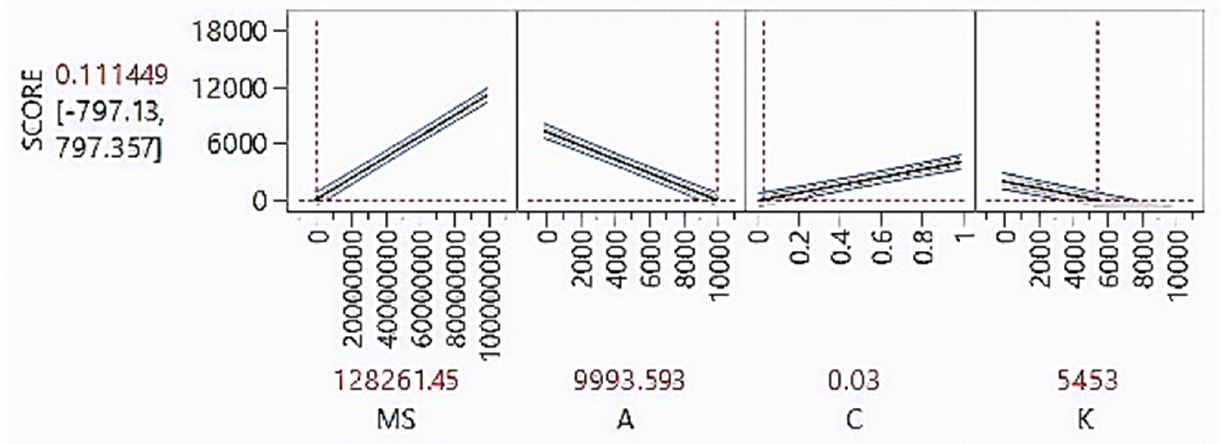
Figure 3. Prediction profiler for the optimized linear model.